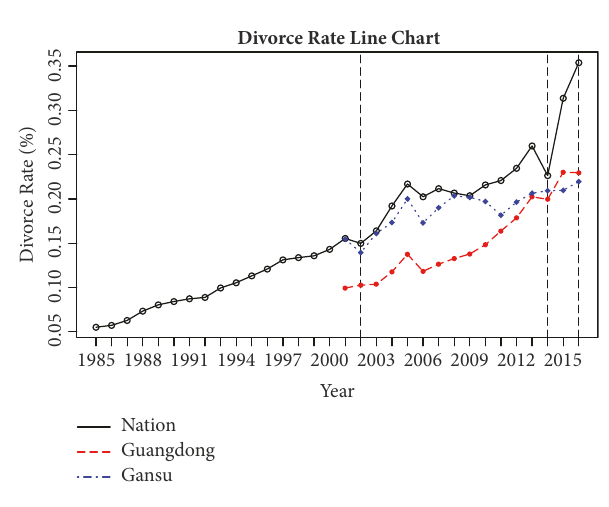
Figure 3: Divorce rate line